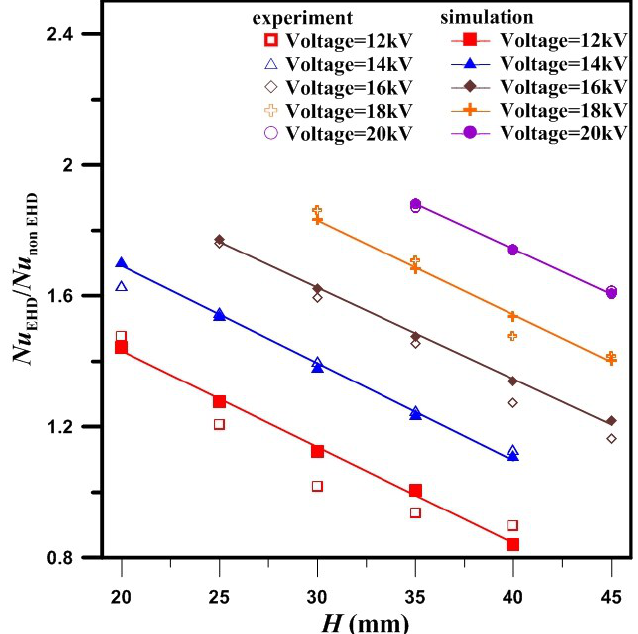
Figure 7. Comparisons of the Nu EHD / Nu nonEHD for the experimental and numerical simulations with different electrode heights ( SL = 100 mm and Δ T = 33 K).